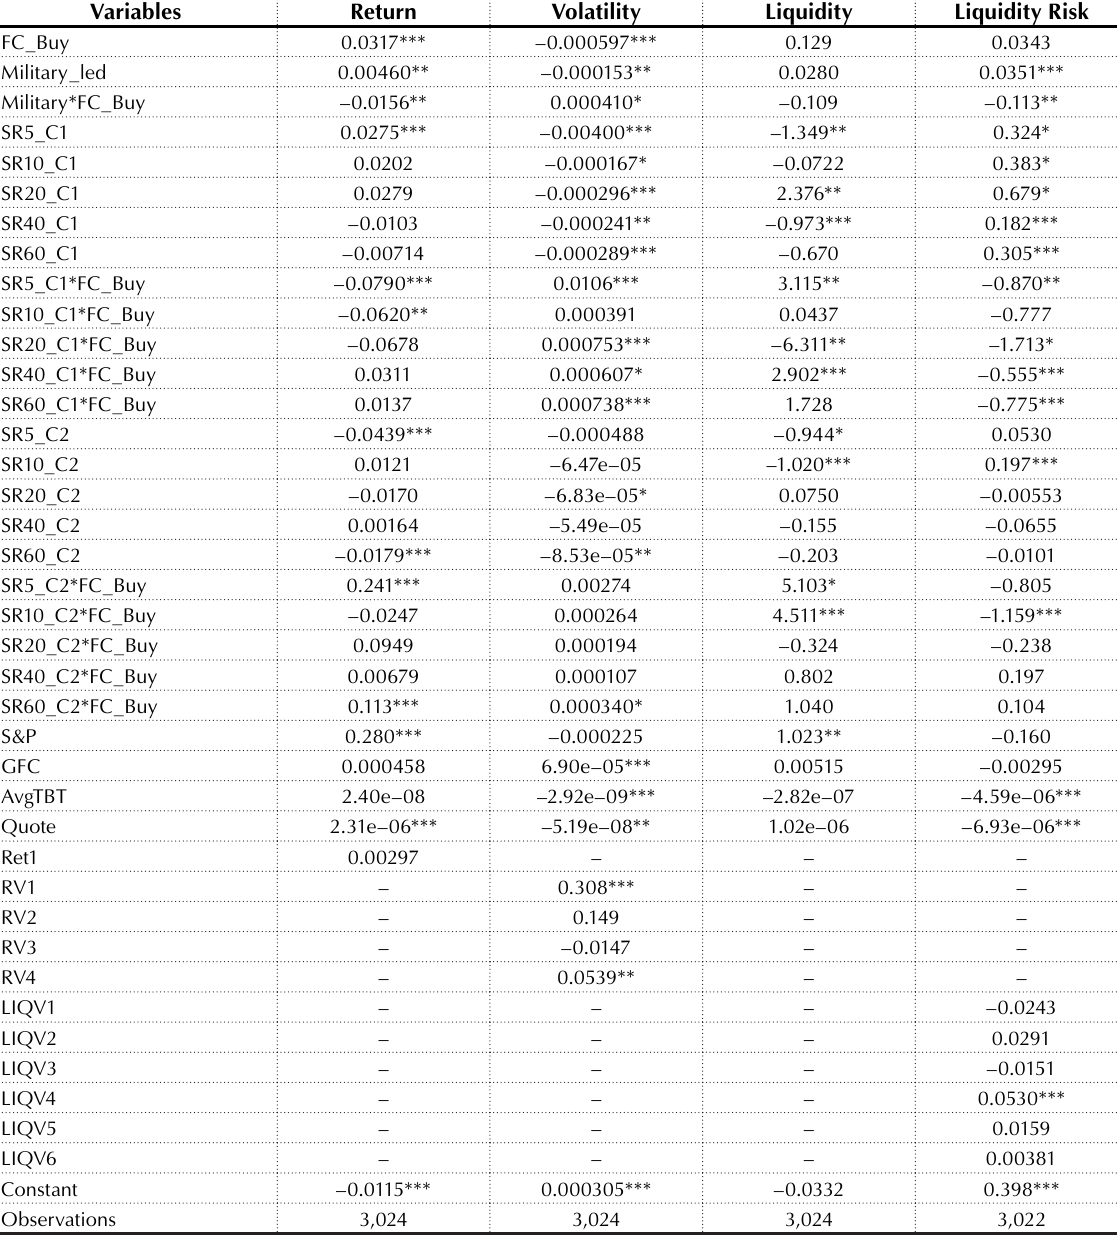
Table 6. Short-run and long-run analyses on the SET